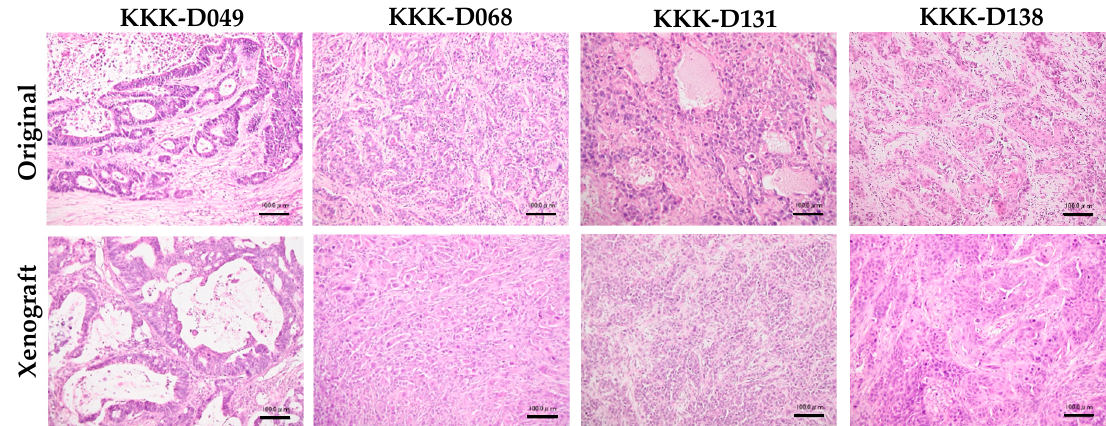
Figure 6. Histological comparison of original tumor tissues from patient (original) and subcutaneous transplanted tissues (xenograft). Bar = 100 μ m.